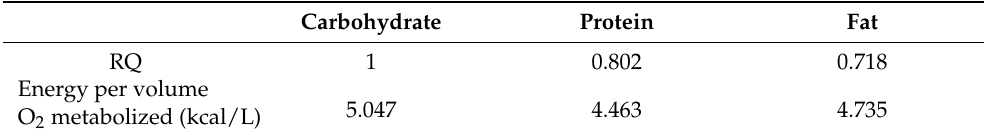
Table A1. Numerical values of RQ and energy per volume O 2 metabolized for carbohydrates, proteins, and fats adapted from